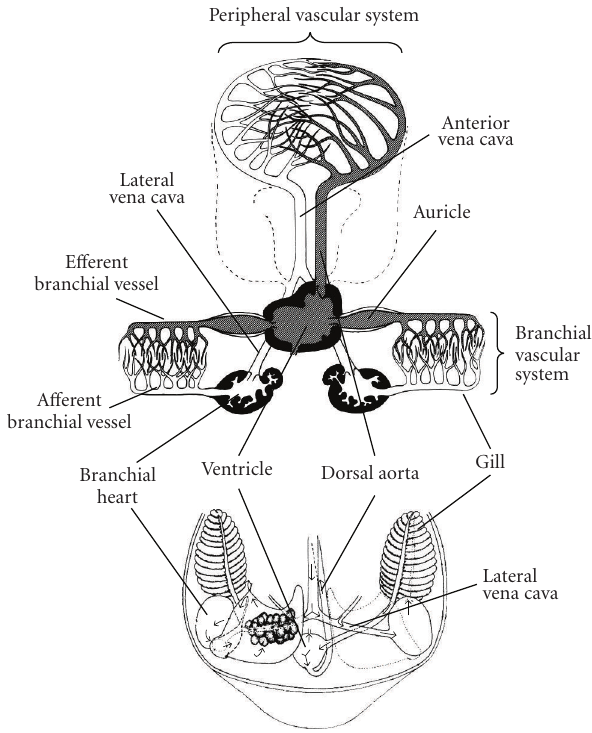
Figure 4: A generalized schematic of the cephalopod molluscs circulatory systems (top) and a more anatomically correct view (bottom), showing the well-developed hearts (a ventricle and two branchial hearts) and complex, endothelial-like lined vascular sys- tems (peripheral and branchial). The cephalopod vascular system is considered “closed” with highly e ffi cient hearts pumping blood at pressures similar to those seen in lower vertebrates (adapted from Smith and Boyle [16], Ruppert et al.